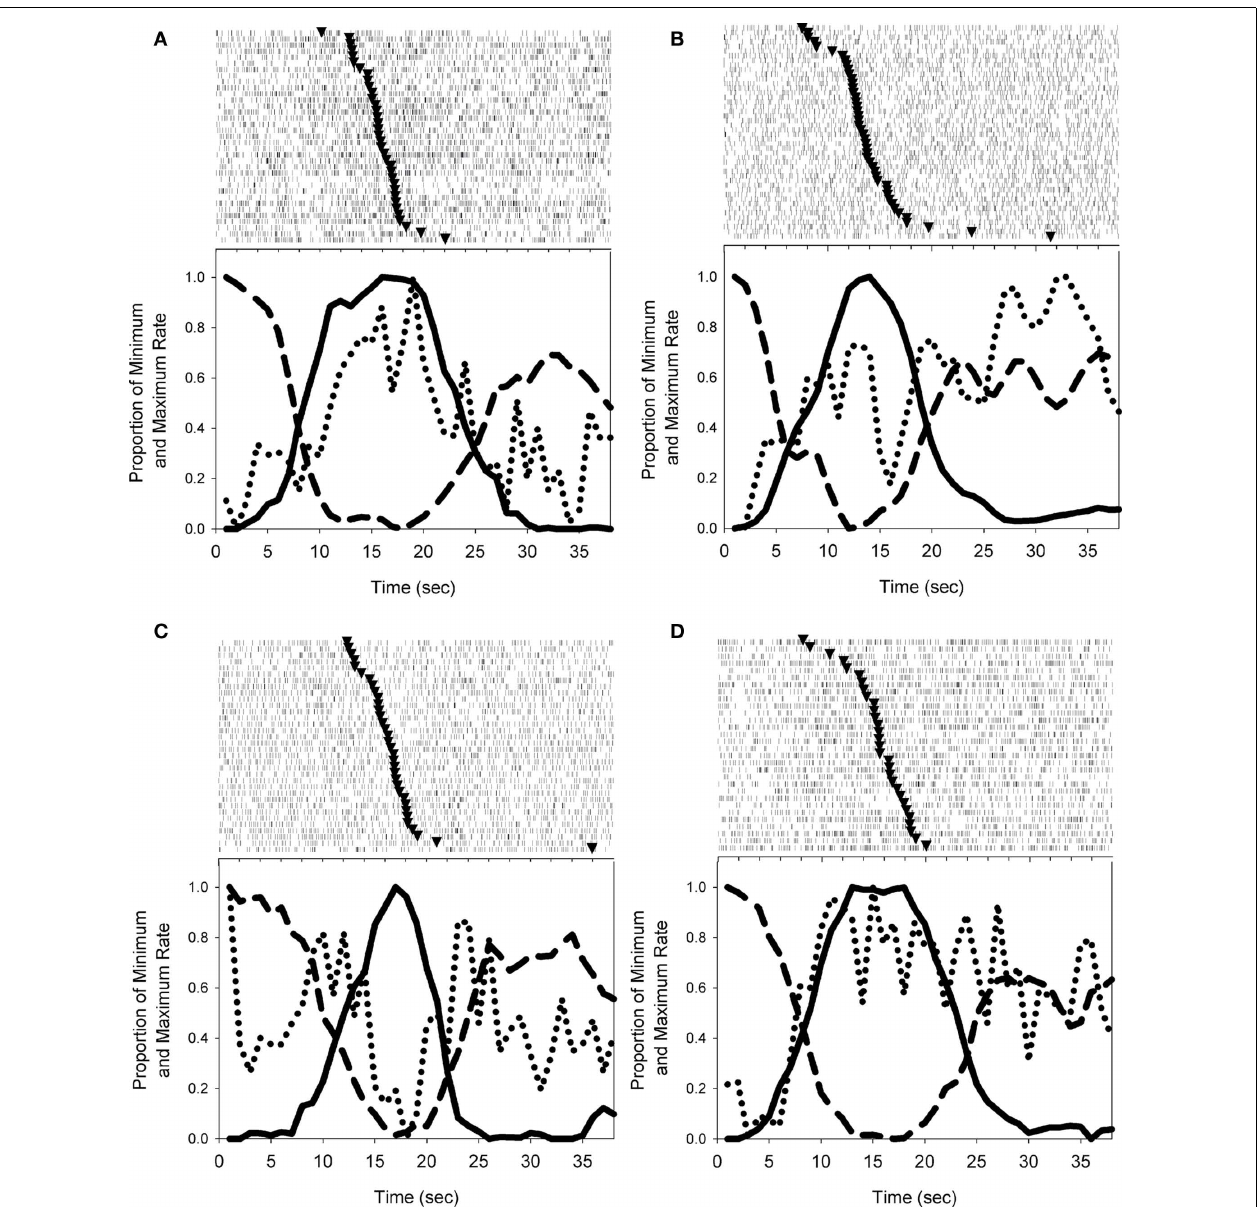
elapses. In (C) , the activity of the cell differs across nosepoking phases (VI versus FI) in an inverted peak shape, but also shows abrupt excitations associated with the transition behaviors. (D) Displays a striatal neuron with both peak-like and ramp-like components.Trials displayed in peri-event rasters were ordered by the midpoint of FI